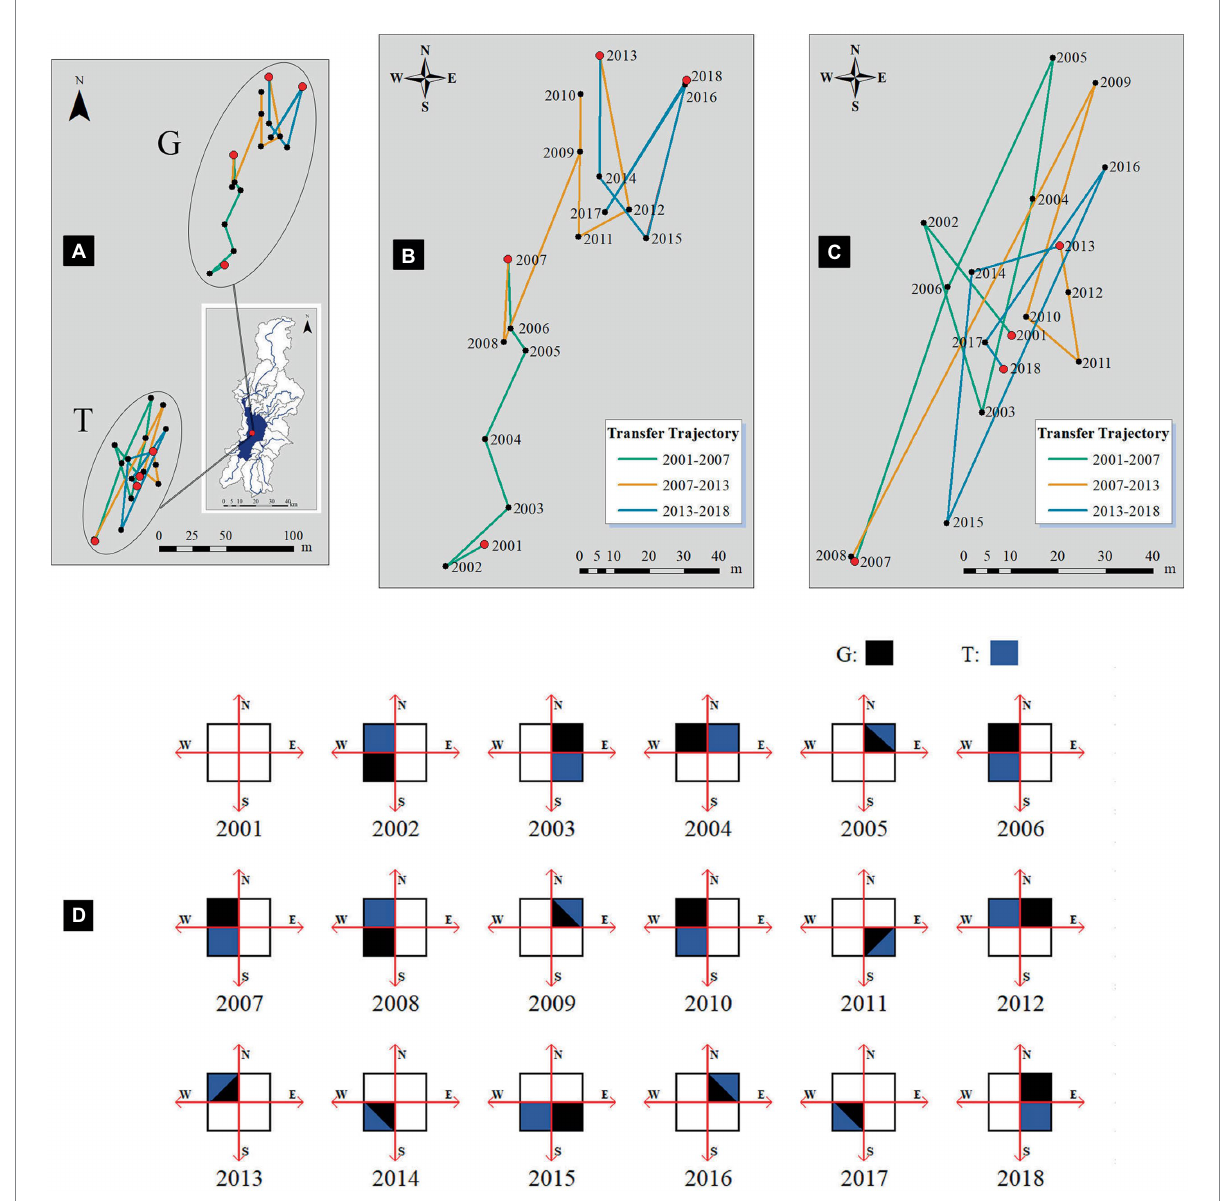
FIGURE 13 Migration trajectories and direction quadrants of spatial influence (G) and LSWT (T) from 2001 to 2018. (A) migration trajectories of G and T; (B) migration trajectory of G; (C) migration trajectory of T; (D) quadrant diagrams of gravity center migration direction of G and